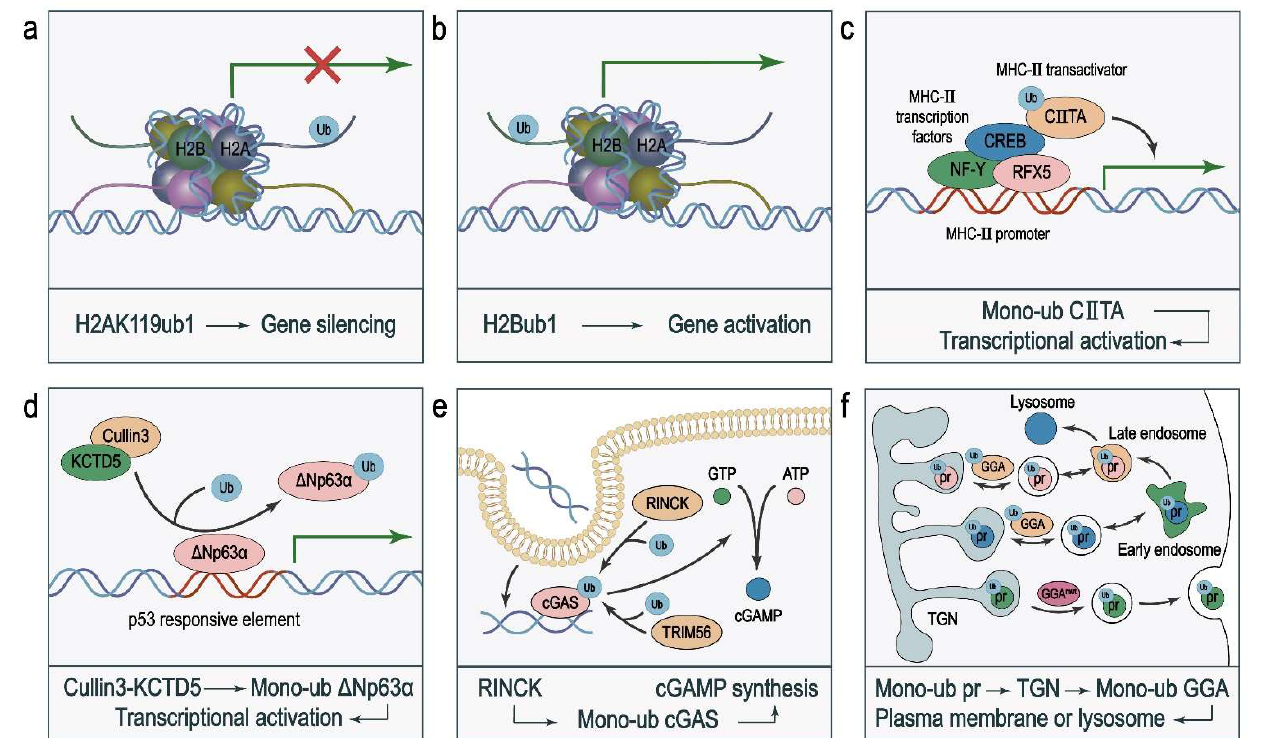
Figure 2. Protein substrates of monoubiquitination. ( a ) H2AK119ub1 mediates gene silencing. ( b ) H2Bub1 mediates transcriptional activation. ( c ) The MHC-II transactivator CIITA is recruited by MHC-II transcription factors (RFX5, CREB, and NF-Y) to the promoters to activate the transcription of MHC-II genes. Monoubiquitination of CIITA enhances its interaction with both transcription factors and the MHC-II gene promoters, leading to transcriptional activation. ( d ) ∆ Np63 α competitively binds to p53-responsive elements to repress the expression of p53 target genes. Cullin3–KCTD5 monoubiquitinates ∆ Np63 α to decrease its DNA-binding affinity, leading to reduced transcriptional repressor activity. ( e ) RINCK or TRIM56 positively regulates cGAMP synthesis by mediating the monoubiquitination and activation of cGAS. ( f ) Monoubiquitination marks proteins (pr) for sorting via the trans-Golgi network (TGN). The Golgi-localized, γ -ear-containing, Arf (ADP-ribosylation factor)-binding (GGA) proteins are clathrin adaptors that bind ubiquitin via their GAT domain to control the trafficking between the TGN, endosome, and plasma membrane or lysosome.